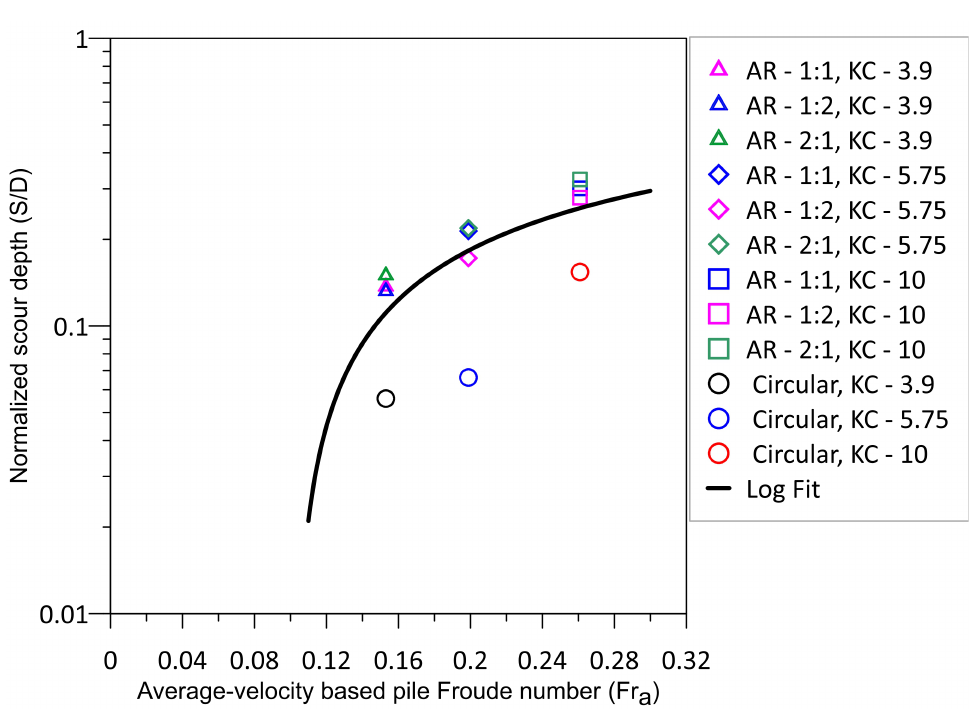
Figure 19. Normalized equilibrium scour depth plotted against the velocity-based Froude number ( Fr a